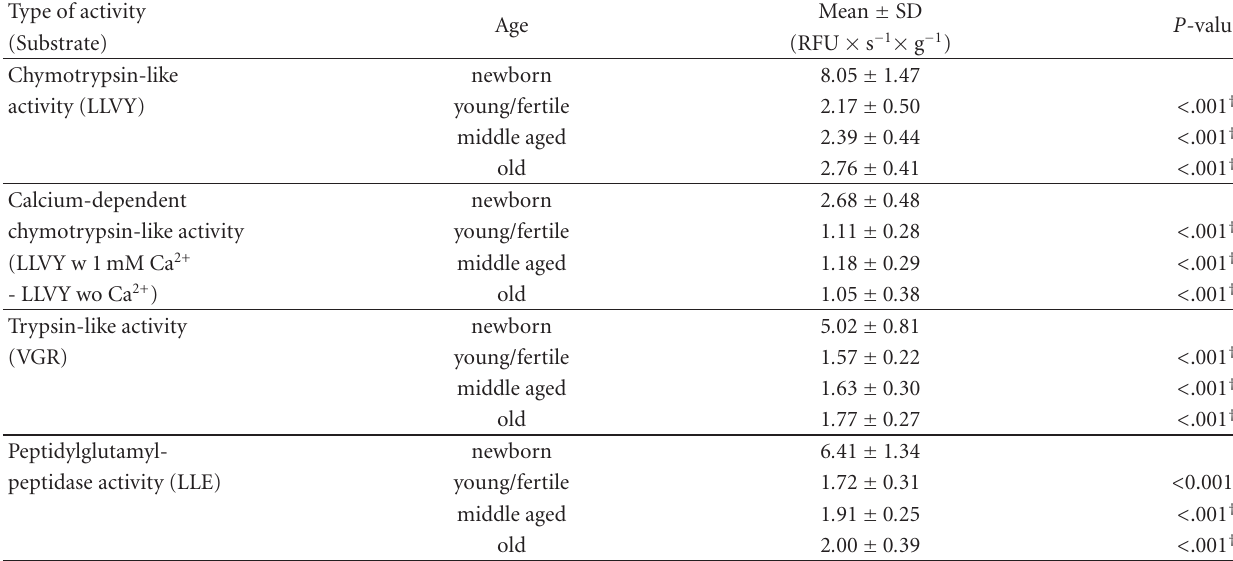
Table 2: Proteasome activity in rat brain.